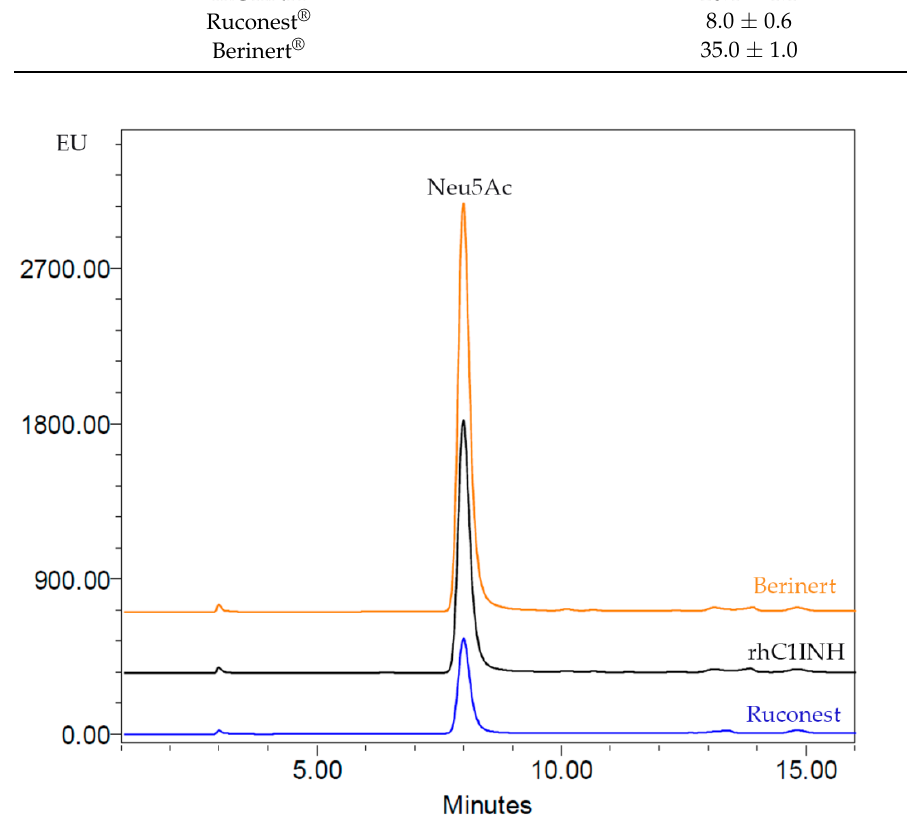
Figure 9. Comparative sialylation profiles of the rhC1INH, Berinert ® and Ruconest ® .